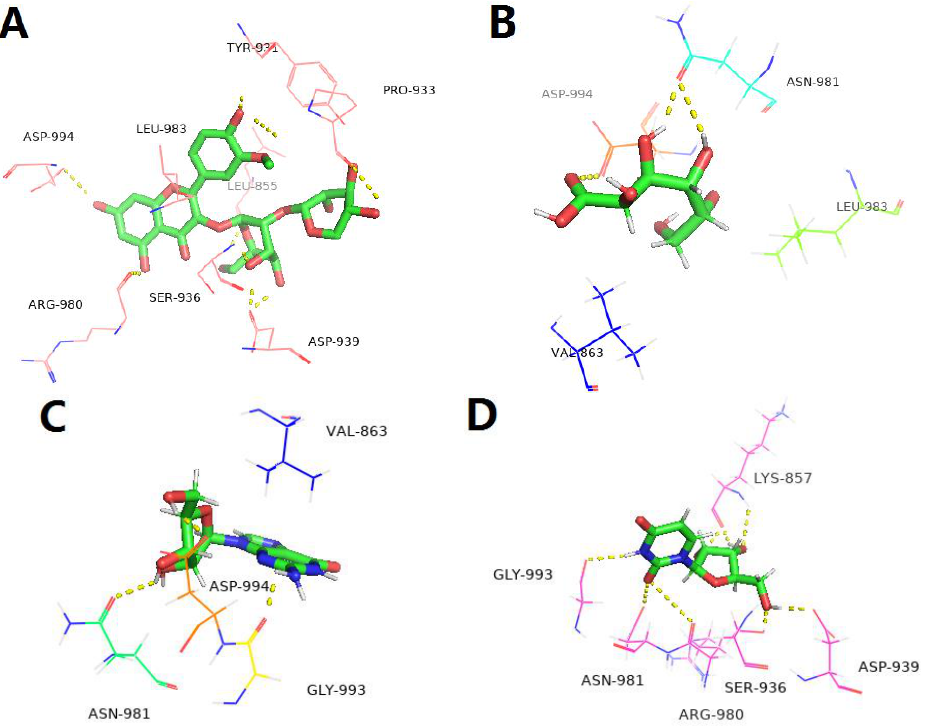
Figure 6. Molecular docking results of JAK2 (PDB: 2B7A) with ( A ) I3XG, ( B ) gluconic acid, ( C ) guanosine and ( D ) uridine.